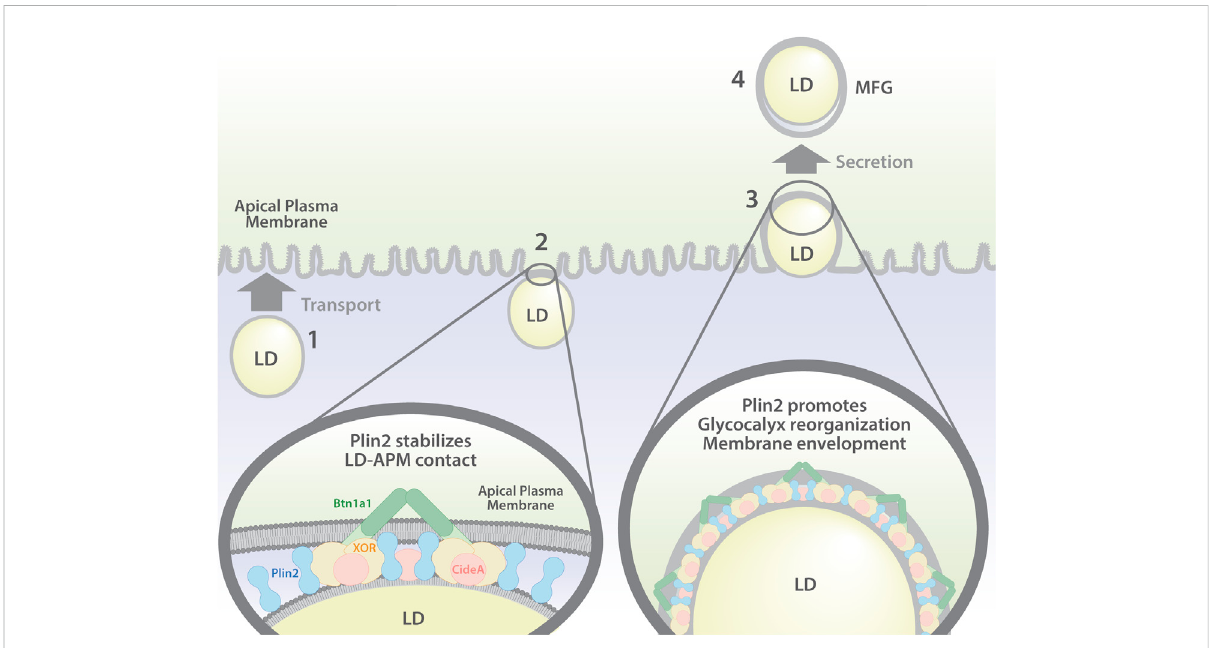
FIGURE 7 Model of LD-APM interactions and proposed roles of Plin2 in apocrine lipid secretion. Apocrine lipid secretion is proposed to involve four distinct steps: (1) LD transport to the APM; (2) formation of LD-APM contacts mediated by interactions between BTN and XOR (and possibly Cidea) and stabilized by Plin2; (3) Plin2 regulated envelopment of APM-bound LD and glycocalyx remodeling; (4) oxytocin dependent secretion of APM- enveloped LD to form milk fat globules